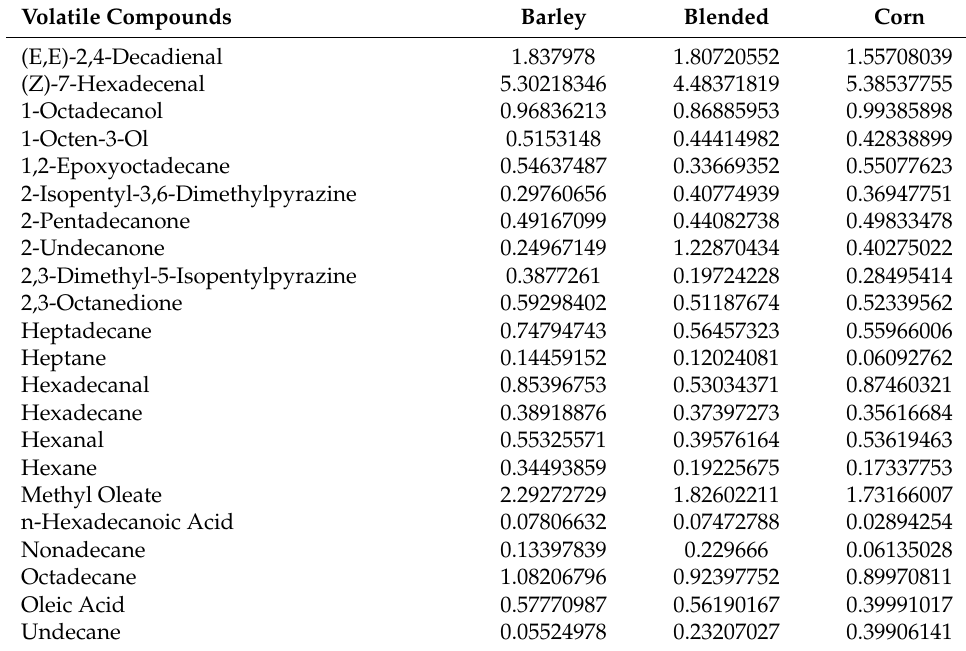
Table 1. Mean of standardized base peak of selected volatile compounds from barley, corn, and blended grain-fed beef